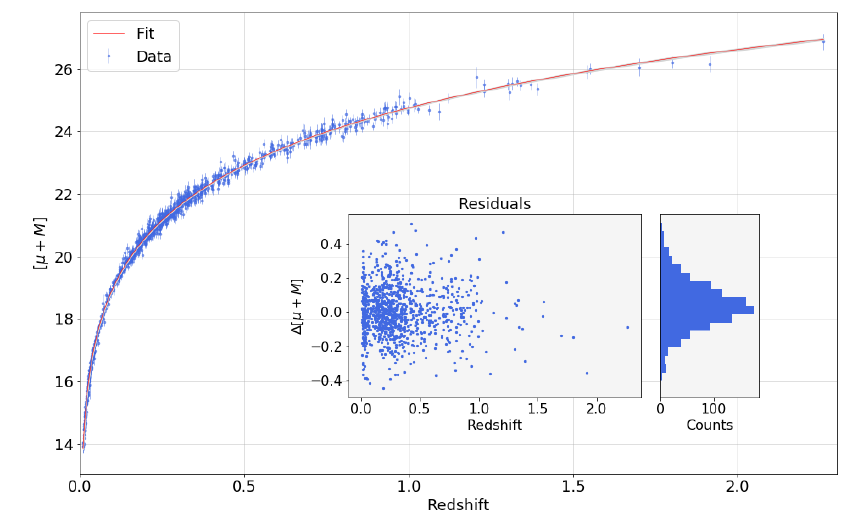
Figure 1. Fitted curve for Delta Gravity model assuming M V = − 19.23. On the right corner, the residual plot for the fitted Data.